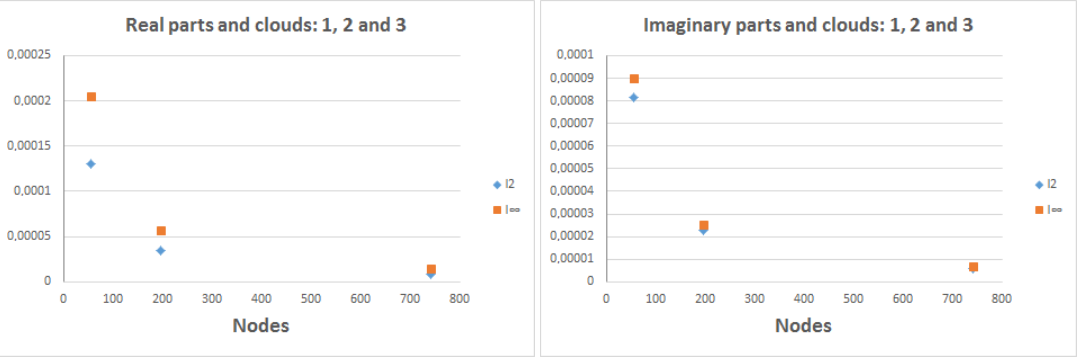
Figure 6. l 2 and l ∞ norms of the errors of the real and imaginary parts for t = 2, respectively versus nodes.